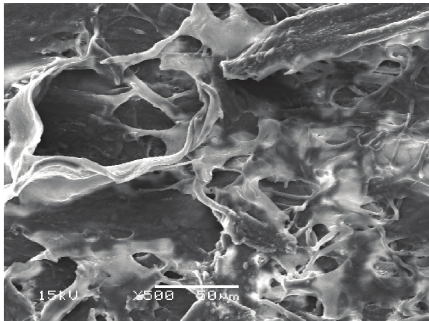
Figure 4: SEM of tissue treated with ALT (300mW) showing crater formation and coagulative damage.